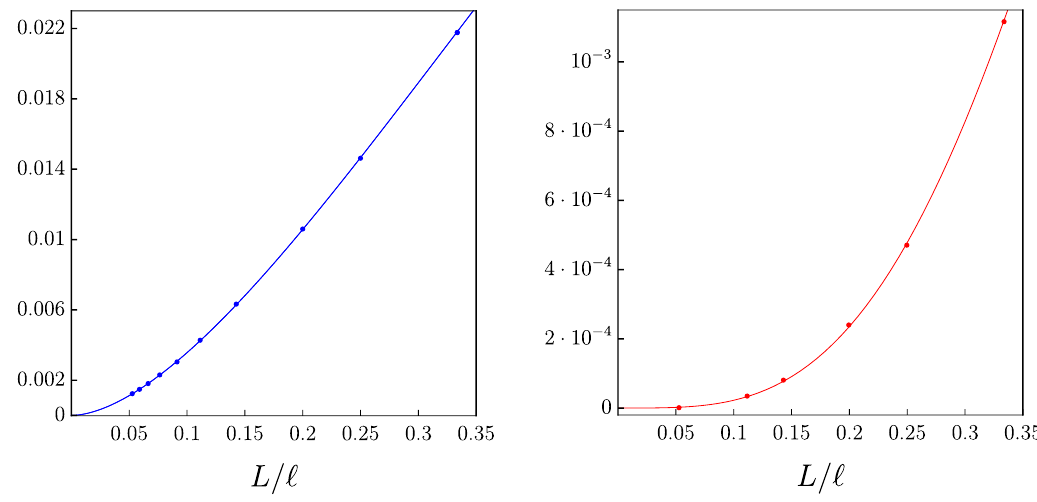
Figure 6 . We plot the reflected entropy (per degree of freedom) for regions A , B , corresponding to two squares of length L separated by a distance ‘ as a function of L/‘ for a free scalar (blue dots) and a free fermion (red dots) in the small- L/‘ region. We also show the trial functions explained in the